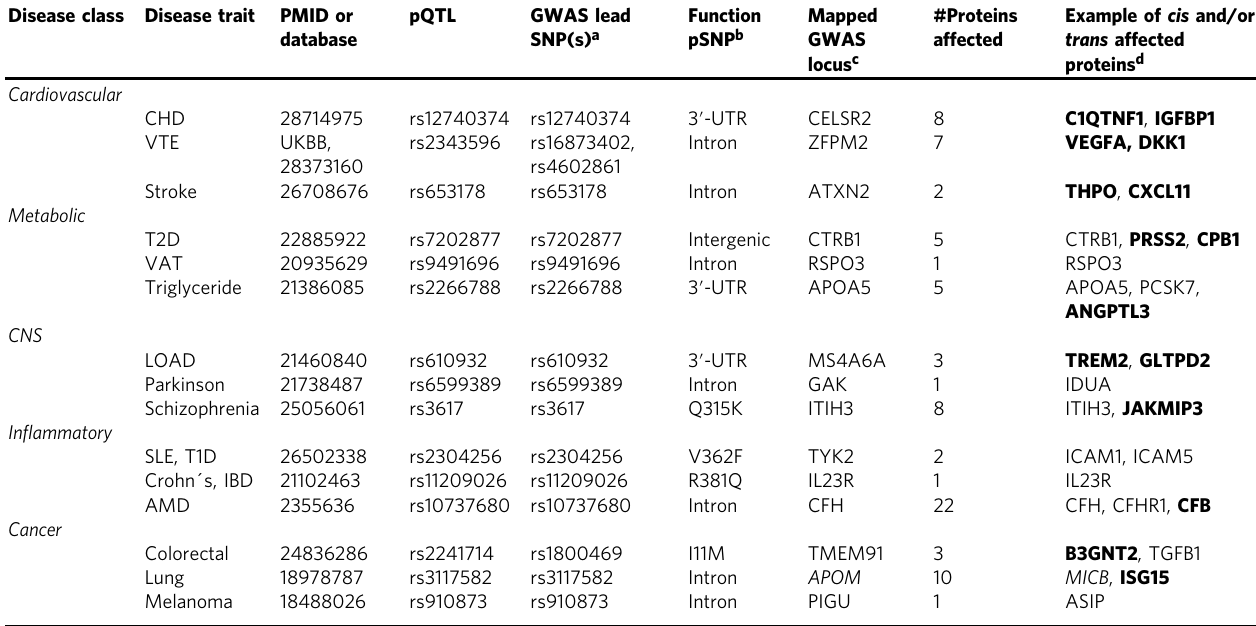
Table 1 Selected examples of exome array variants affecting serum protein levels and complex disease. Disease class Disease trait PMID or